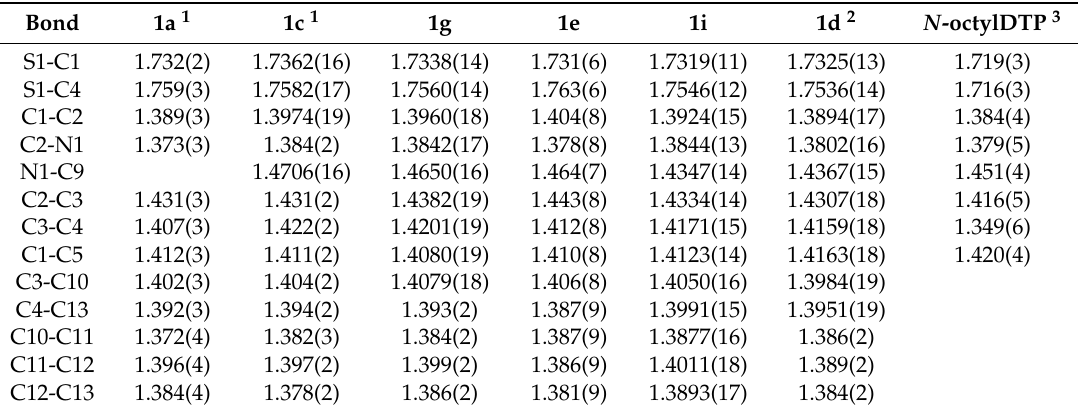
Table 1. Selected bond lengths (Å) for various bis[1]benzothieno[3,2 ‐ b :2 ′ ,3 ′‐ d ]pyrroles and N ‐